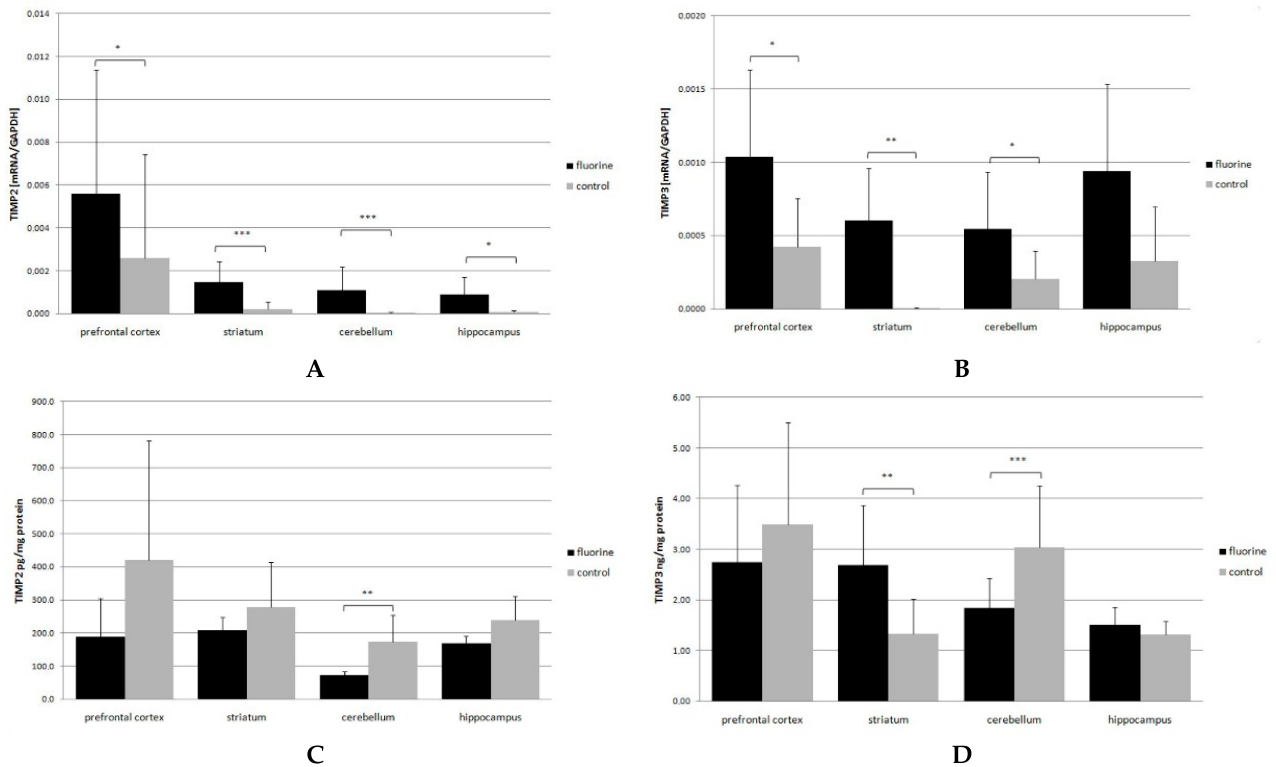
Figure 4. TIMP2 and TIMP3 mRNA ( A , B ) and protein ( C , D ) expression in the prefrontal cortex, striatum, cerebellum and hippocampus. Black bars represent means ± SD of protein ( A , B )/mRNA ( C , D ) level in F-exposed group, while gray bars represent controls. * p ≤ 0.05, ** p ≤ 0.005, *** p ≤ 0.001 (Mann–Whitney U test), n = 6.